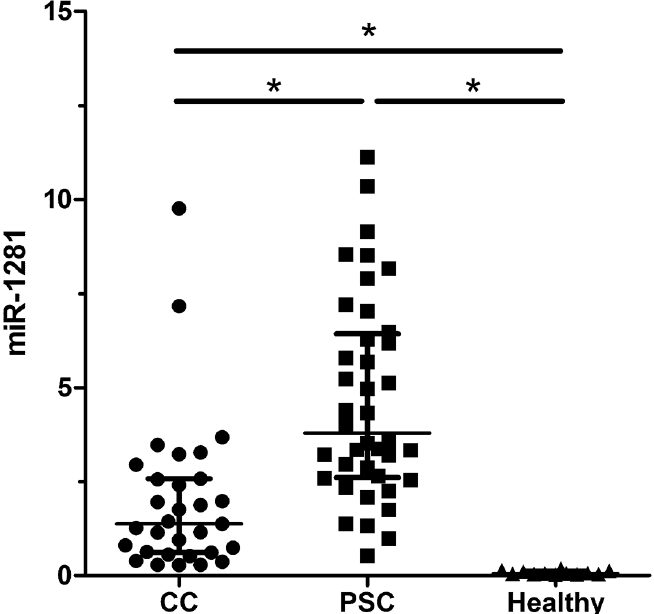
Fig 1. MiRNA analysis in serum. Serum validation analysis for patients with primary sclerosing cholangitis (PSC) (n = 40) and cholangiocarcinoma (CC) (n = 31) revealed differentially expressed miRNAs. Fig 1 shows the result for